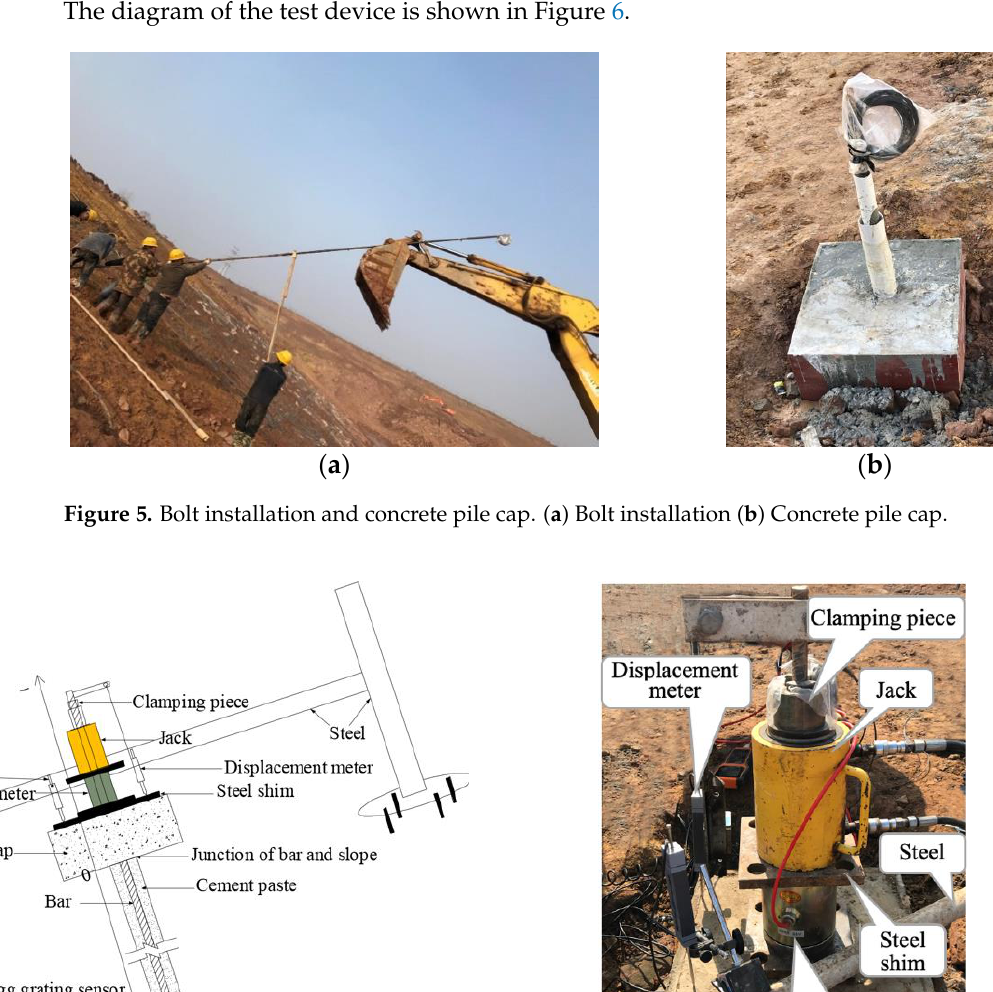
Figure 5. Bolt installation and concrete pile cap. ( a ) Bolt installation ( b ) Concrete pile cap